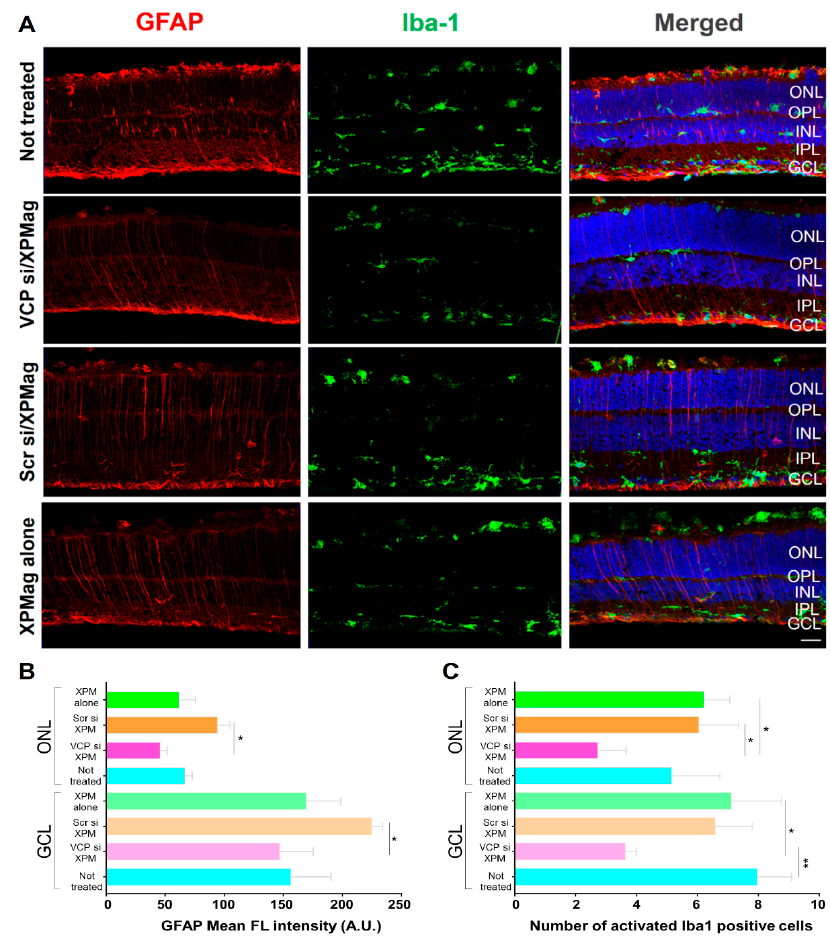
Figure 6. Reverse Magnetofection does not activate associated gliosis or microglial activation and reducing VCP expression decreased retinal stress and inflammation in RHO P23H retinal explants. Retinae of RHO P23H transgenic rats were explanted on postnatal day 12 and cultured in vitro for three days. Retinae were treated with 50 nM VCP si/XPMag, 50 nM Scr si/XPMag, and XPMag alone using Reverse Magnetofection. ( A ) Immunofluorescence labeling in cryosections designates the location of glial fibrillary acidic protein (GFAP) (red staining) and ionized calcium-binding adapter molecule 1 (Iba1) (green staining) as counterstaining of the nuclei by DAPI (blue). ( B ) Quantification of GFAP mean immunofluorescence intensity in the ONL and GCL. ONL or GCL were selected for each image, and the mean maximum intensity was assessed using the Zen 2.3 software. Reverse Magnetofection does not further activate retinal gliosis, and VCP silencing reduced the GFAP fluorescence intensity in the ONL and GCL compared to the scrambled sıRNA treated retinae. ( C ) Quantification of activated (round-shaped) Iba1 positive cells in ONL and GCL. Retinae treated with VCP siRNA/XPMag via Reverse Magnetofection showed a significant decrease in retinal inflammation. The values were quantified by scoring several images from three retinae ( n = 3) per treatment for not treated, VCP si/XPM, Scr/XPM, and XPM alone. Data plotted as mean ± SD. One-way ANOVA, * p < 0.05 and ** p < 0.01. Scale bar 50 µ m. Abbreviations: VCP si: VCP siRNA, Scr si: scrambled siRNA, ONL: outer nuclear layer, OPL: outer plexiform layer, INL: inner nuclear layer, IPL: inner plexiform layer, GCL: ganglion cell layer, GFAP: glial fibrillary acidic protein, and Iba-1: ionized calcium-binding adapter molecule